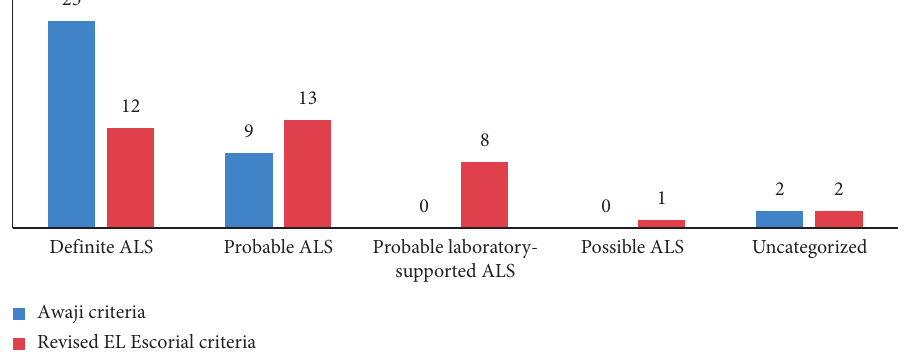
Figure 3: Diagnostic categories for ALS patients with a duration of evolution of the disease from 7 to 12 months, according to the AC and